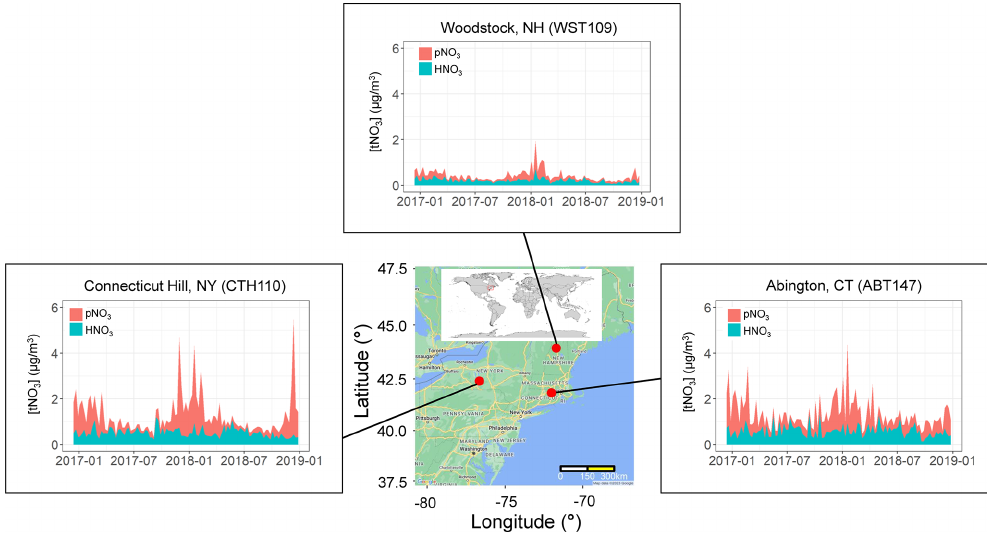
Figure 1. Location and nitrate concentrations (nitric acid (HNO 3 ), particulate nitrate (pNO 3 ), and total nitrate (tNO 3 = HNO 3 + pNO 3 )) from December 2016–2018 of the three northeastern CASTNET monitoring sites included in the study. The map was created using Google Maps (Map data © 2022